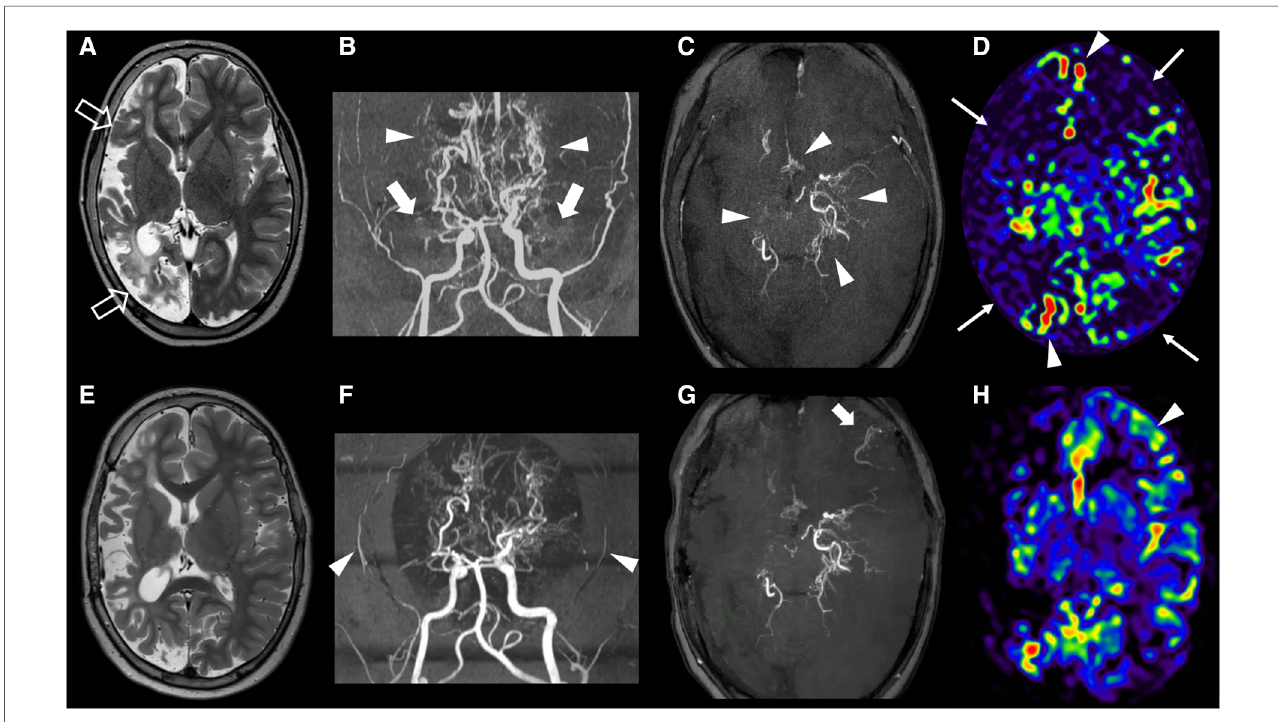
FIGURE 1 Clinical and imaging fi ndings. Brain MRI and MR angiography of the subject performed before revascularization at 8 years of age ( A – D ) and at last follow-up, after eleven months ( E – H ). A) Axial T2-weighted image shows a chronic arterial ischemic infarct in the right cerebral hemisphere (empty arrows) with relative sparing of the mesial frontal and insular regions. ( B,C ) Brain MR angiography with 3D reconstruction, frontal view ( B ) and axial MinIP reconstruction ( C ) demonstrate bilateral stenosis of the right supraclinoid portions of the internal carotid arteries with absent fl ow signal in the middle cerebral arteries (thick arrows) and anterior cerebral arteries, and multiple moyamoya collaterals (arrowheads). Note the initial distal stenosis of the left posterior cerebral artery. ( D ) Brain arterial spin labeling MR perfusion reveals reduced signal in the right cerebral hemisphere and in the left anterior frontal and parietal lobes (thin arrows) with bilateral arterial transit artifacts (arrowheads). ( E ) Follow-up axial T2-weighted image performed 11 months after the revascularization procedure shows no other ischemic infarcts. ( F,G ) Corresponding MR angiography images reveal reduction of fl ow signal in the super fi cial temporal arteries (arrowheads), absence of collateral formation at surgical site on the right, and a limited region of revascularization in the left fronto-basal region (thick arrow). ( H ) Arterial spin labeling MR perfusion demonstrated increased CBF only in the left fronto-basal region